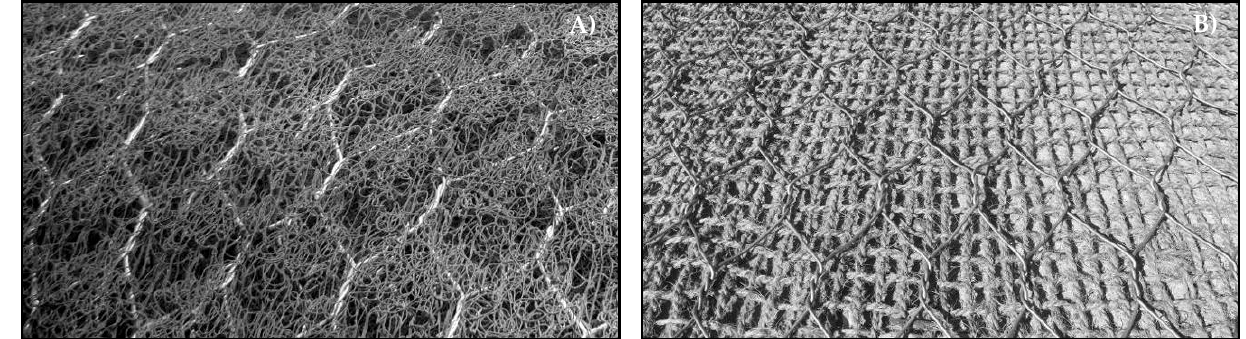
Figure 3. Details of Macmat® R geomat ( A ) and degradable mat ( B ).